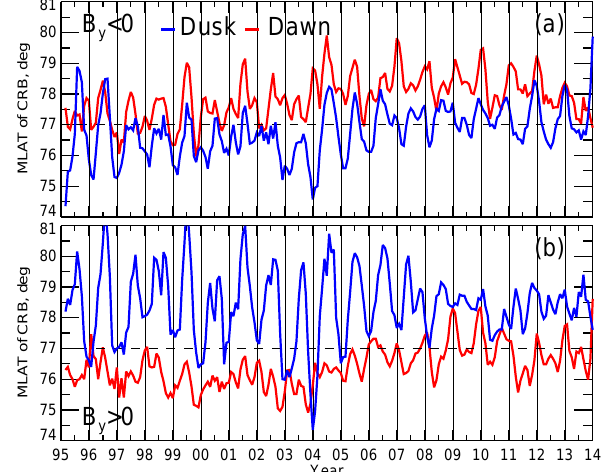
Figure 7. Magnetic latitudes of the convection reversal bound- ary for (a) B y < 0 and (b) B y > 0 (IMF B z < 0 in both cases, B − t = [ − 4,0]nT). Monthly averaged SuperDARN convection maps for 1995–2013 were considered. The horizontal dashed line is the latitude of 77 ◦ given for convenience of